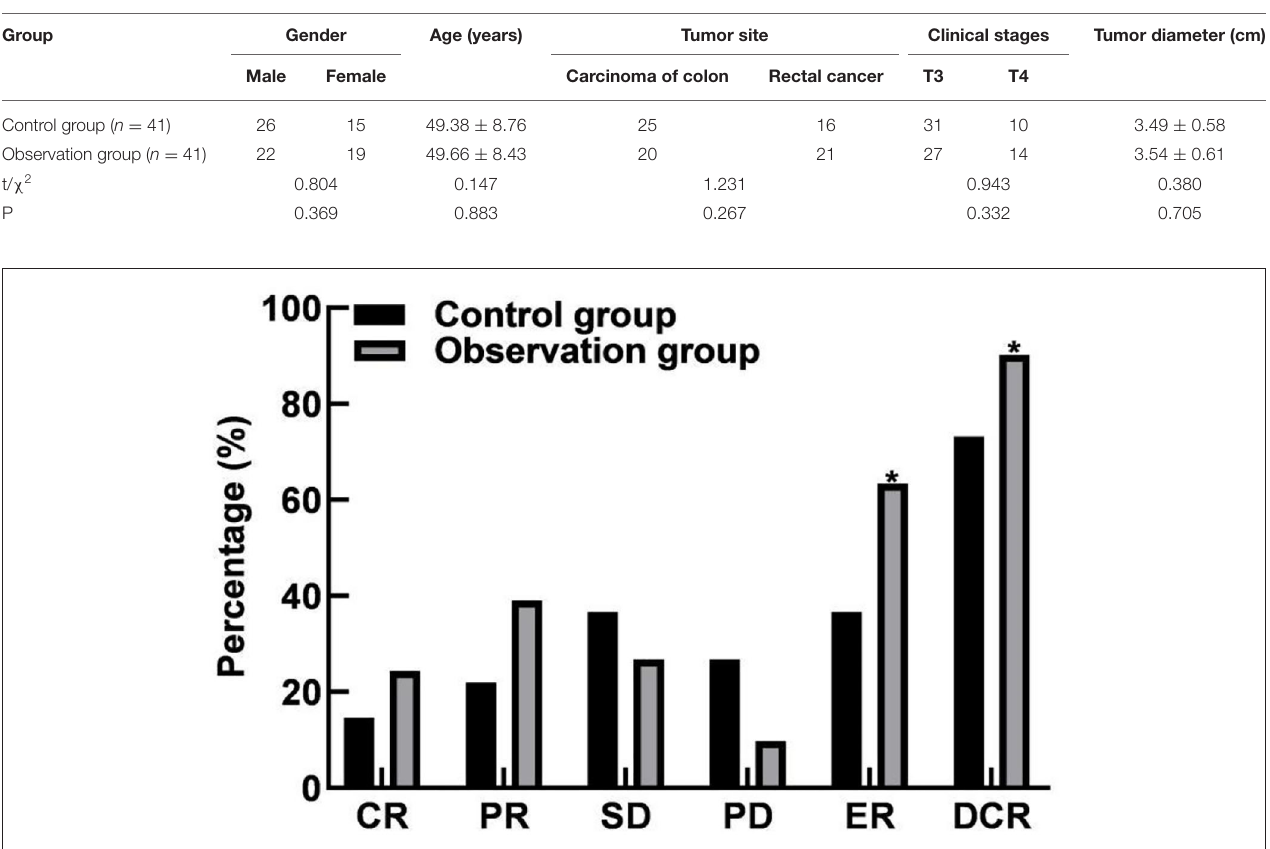
TABLE 1 | Comparison of general data between the two groups.